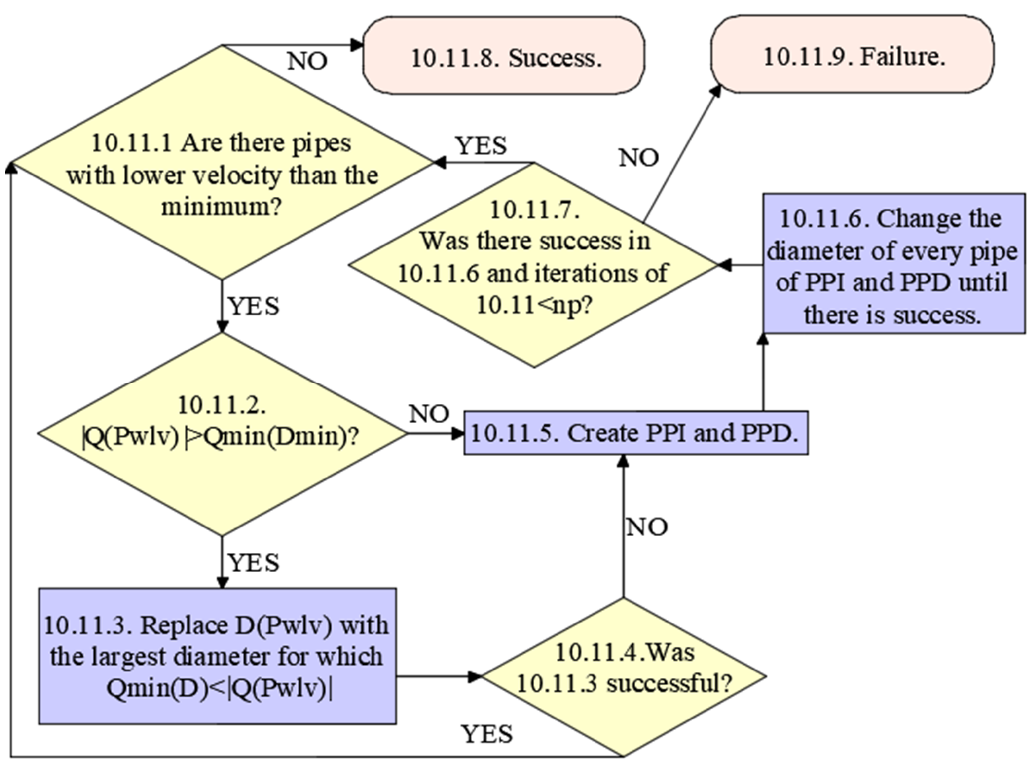
Figure 7. Minimum velocity constraint handling.